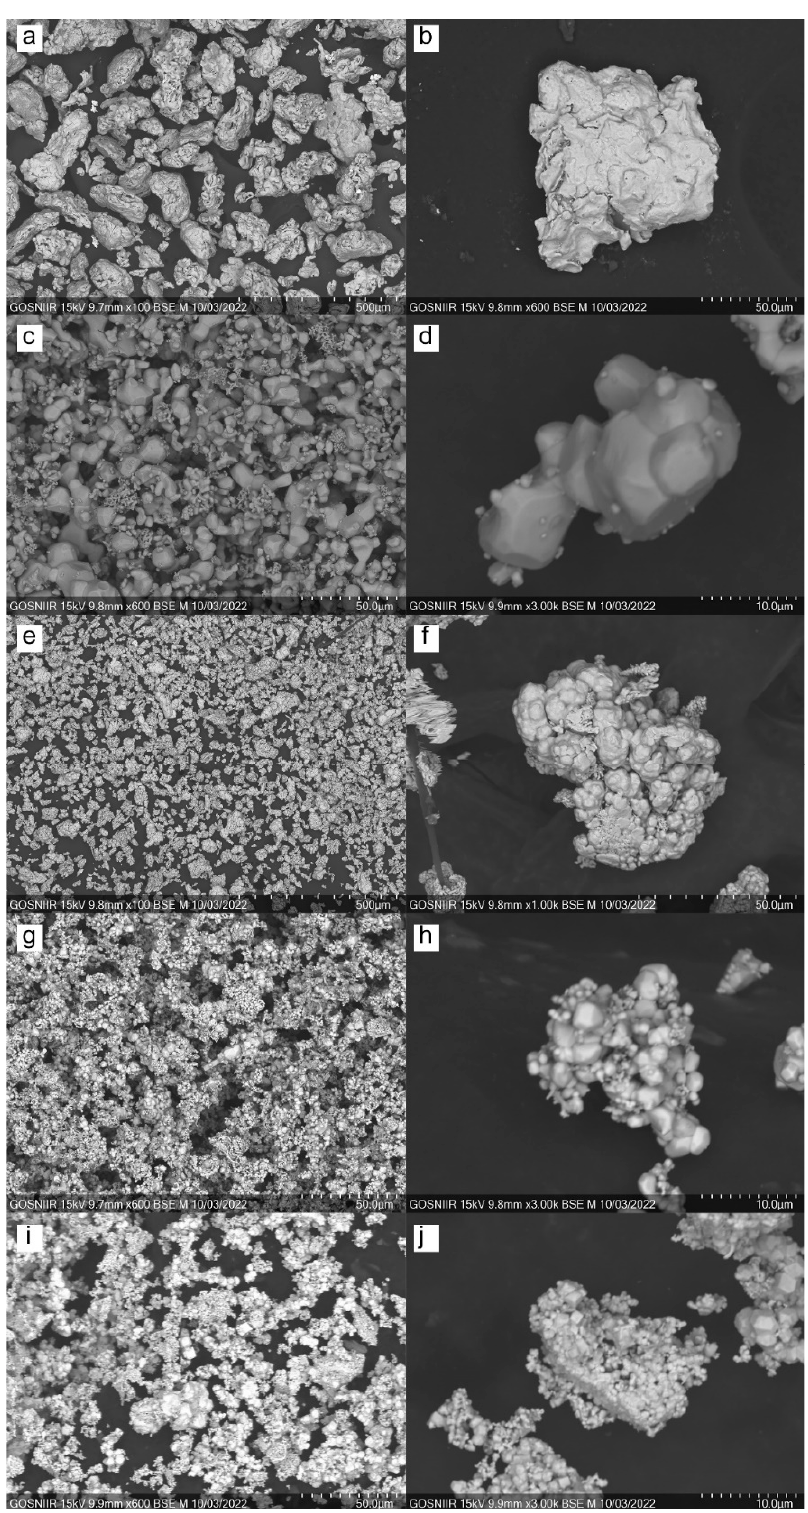
Figure 1. Morphology of the elemental powders: ( a , b )—Fe; ( c , d )—Cr; ( e , f )—Ni; ( g , h )—Mo; ( i , j )—W. Two compositions were selected for preparation of powder mixtures: 35Fe30Cr20Ni10 Mo5W (wt.%) and 30Fe30Cr20Ni10Mo10W